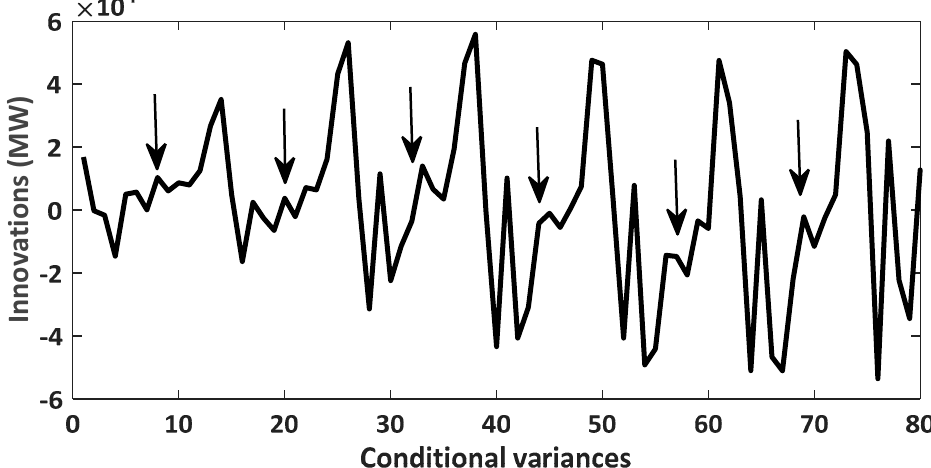
Figure 6. Innovation plot showing clusters of volatility (pointers show the clusters).